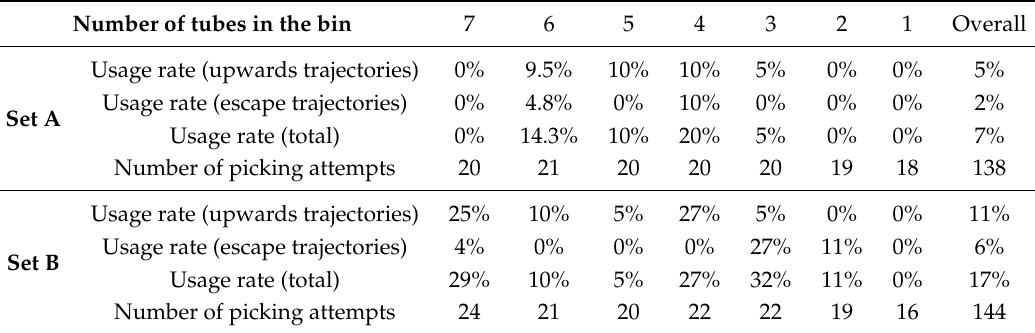
Table 5. Percentages of picking attempts where trajectory simulation was performed and frequency of both types of trajectories on the chosen